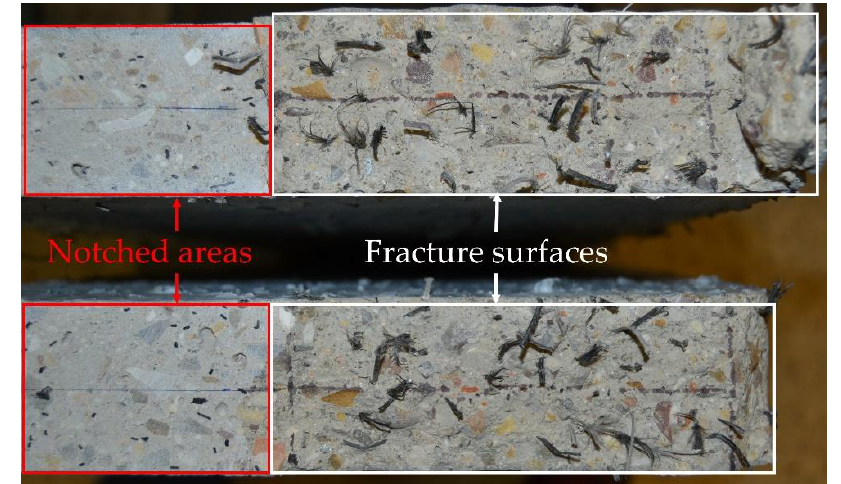
Figure 8. Fracture surfaces of one specimen prepared for the fibre counting.